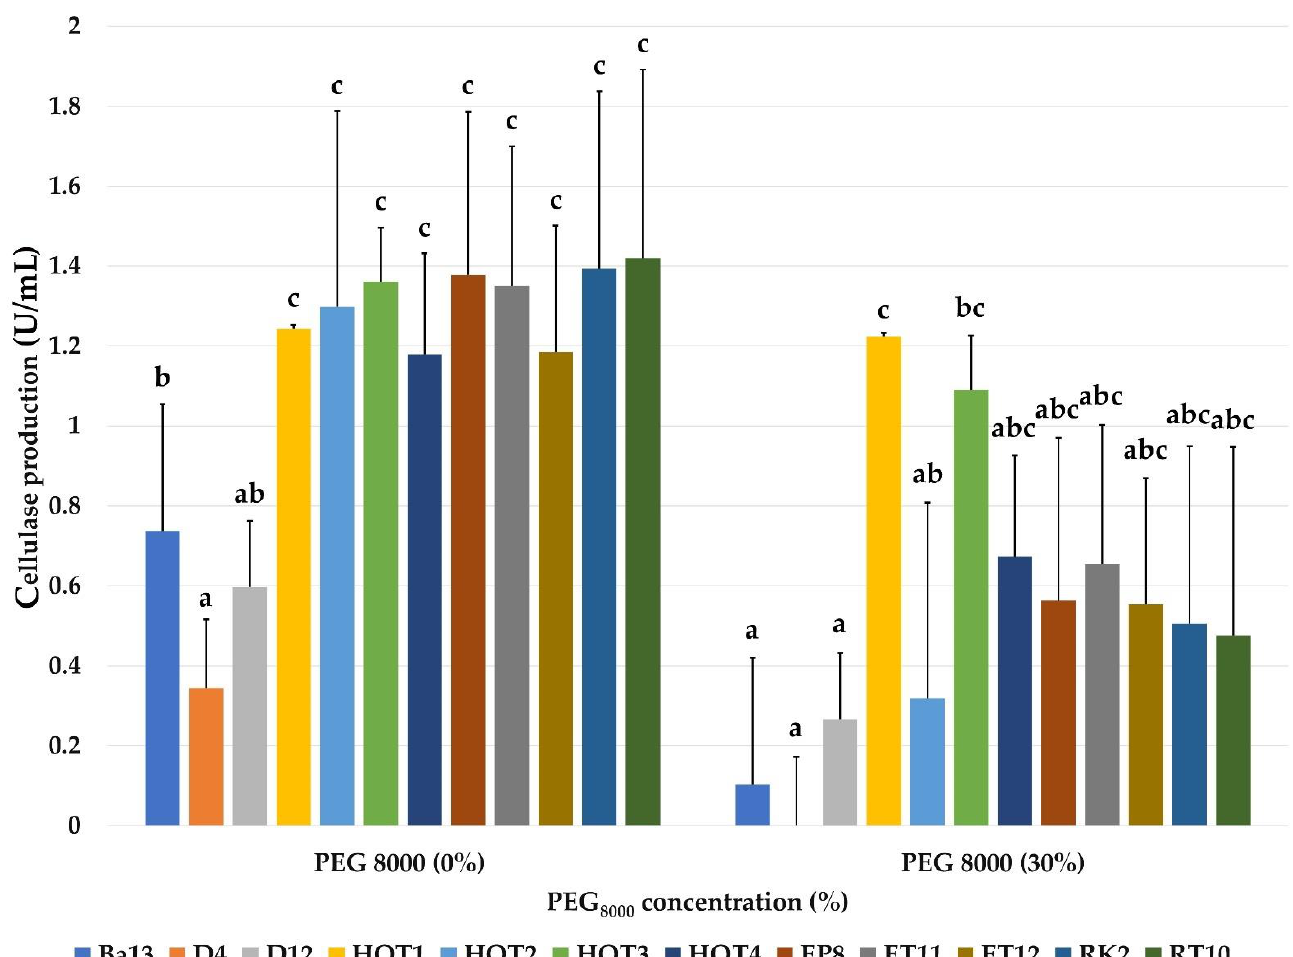
Figure 7. Effect of water stress on the production of CMCase in CMC broth (1%) of the 12 isolates tested. The results are expressed as the mean-standard error of the values of the enzymatic unit in duplicate. The effects of the PEG 8000 concentrations corresponding to each treatment and not sharing the same letters are significantly different according to Tukey ’ s post hoc HSD test.